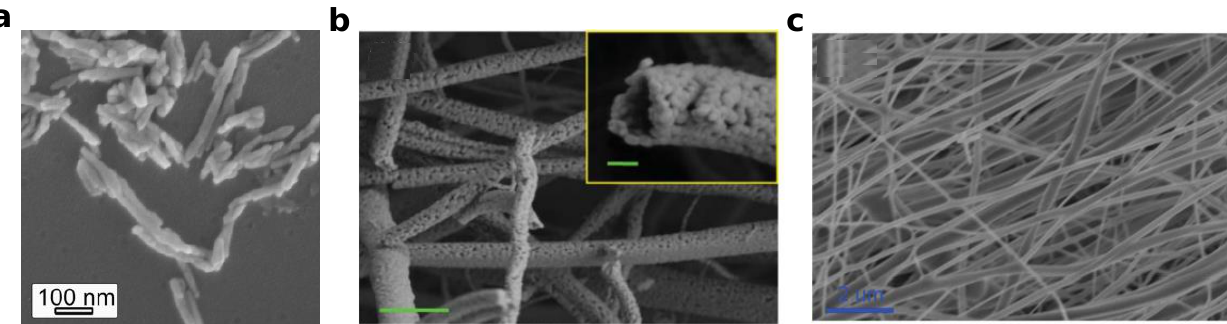
Figure 8. Field-emission scanning electron microscopy (FE-SEM) micrographs of the synthesized nanofibers based on ( a ) ZnAl 2 O 4 :Nd, Ce, ( b ) ZnAl 2 O 4 :Cr. Reprinted with permission from [40]. Copyright 2012, Royal Society of Chemistry Publishing. And ( c ) ZnAl 2 O 4 :Nd. Reprinted with permission from [41]. Copyright 2013, American Scientific Publishers.